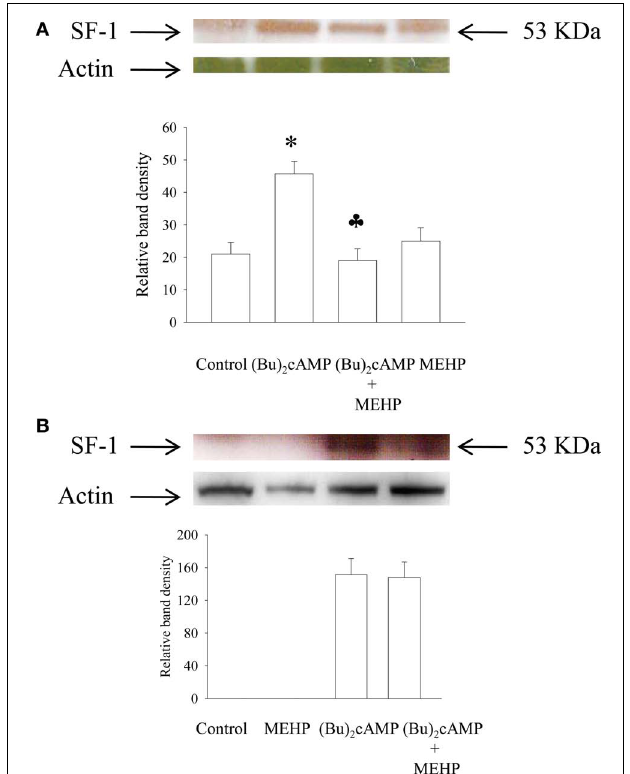
FIGURE 5 | Effects of MEHP on SF-1 protein expression in Leydig cell progenitors (A) and immature granulosa cells (B) stimulated with (Bu) 2 cAMP. The cells were pretreated with MEHP (250 μ M) or culture medium alone for 24h and thereafter incubated with (Bu) 2 cAMP (1mM) in the presence or absence of this same concentration of MEHP for an additional 24h.The cells were lysed and whole cell lysates (50 μ g protein) employed to analyze the levels of SF-1 protein by western blotting as described in Section “Materials and Methods.” Each SF-1-specific band was quantified using NIH Image software and normalized to the optical density of actin.The mean values ± SEM for three independent steroidogenic cell preparations are presented. * p < 0.05 compared to treatment with untreated control; ♣ p < 0.05 compared to treatment with (Bu) 2